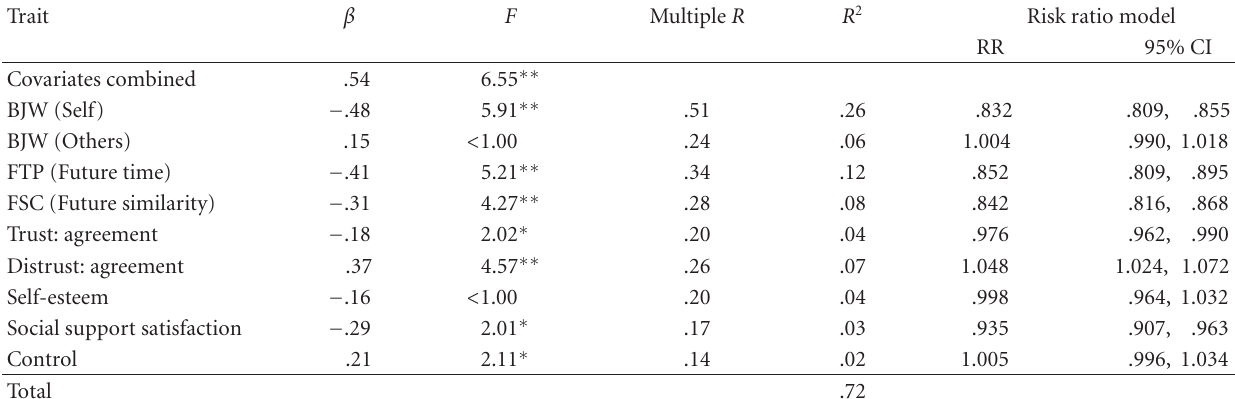
Table 5: Relative risk of death associated with cognitive beliefs, future perspectives, and related traits after adjusting for three covariates entered in the multiple regression